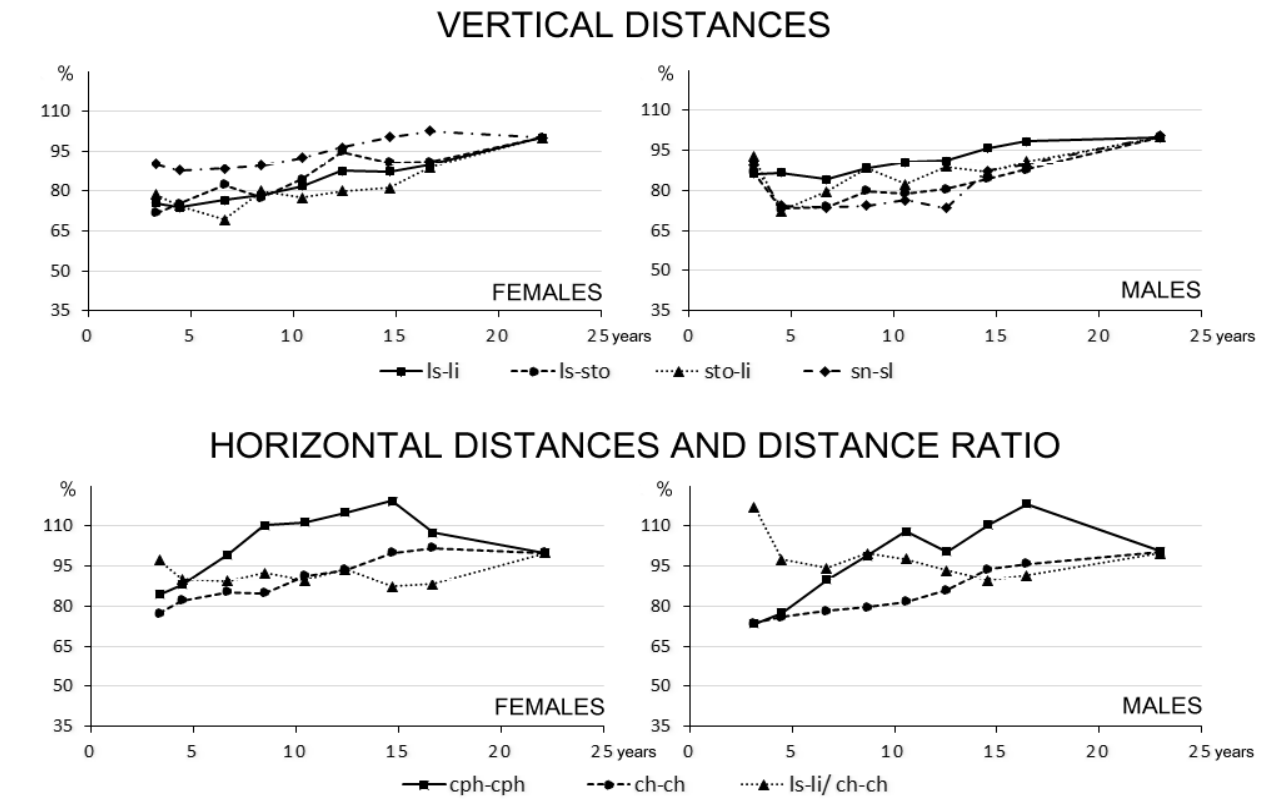
Figure 3. Age-related variations of soft tissue lip distances and distance ratio in females and males.